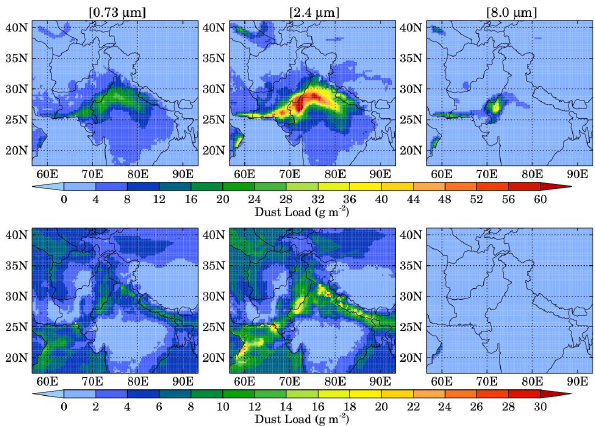
Fig. 5. Spatial distributions of WRF-Chem simulated daytime (09:30 to 16:30IST) average boundary layer (top panels) and free tropospheric (bottom panels) integrated dust load over the model domain during 17–22 April 2010. The distributions are shown at 0.73, 2.4 and 8.0µm effective radii, representing accumulation, coarse and giant mode dust particles,